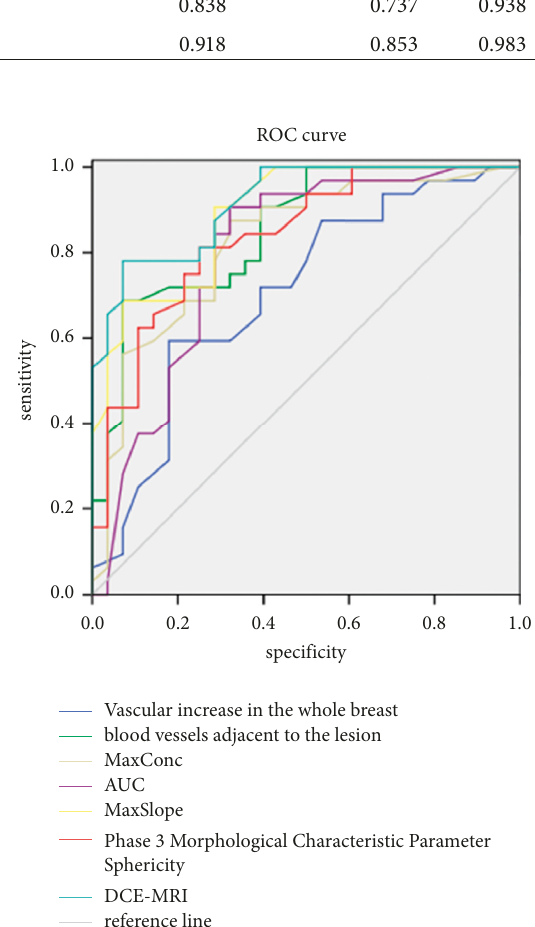
Figure 3: ROC curve of DCE-MRI predicting breast cancer recurrence